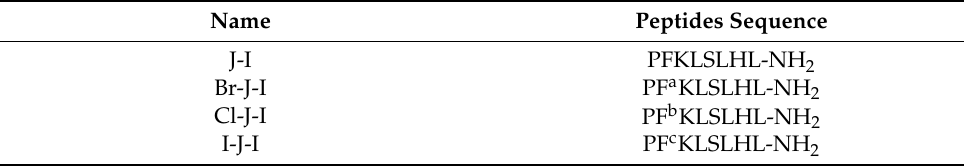
Table 1. Amino acid sequence of J-I, Br-J-I, Cl-J-I, and I-J-I. Name